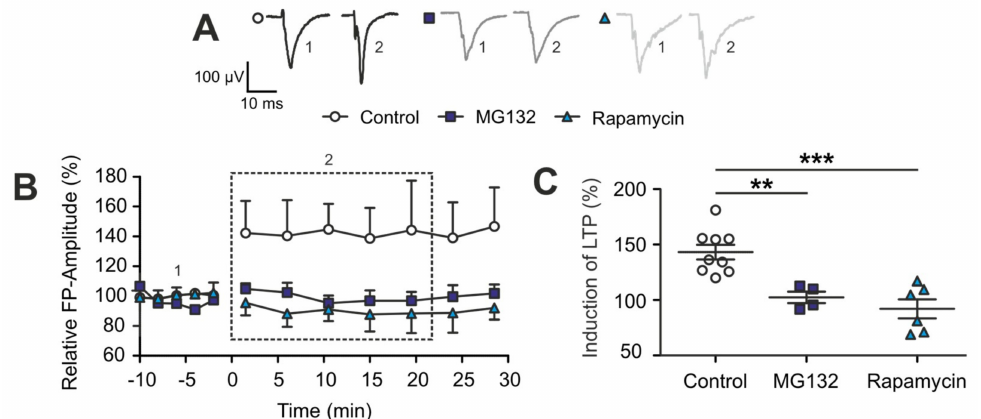
Figure 5. Pharmacological modulation of the two protein degradation systems induced TBI-like changes in l-LTP. ( A ) Representative voltage traces of evoked FPs recorded before (Pre-TBS, baseline, 1 in ( B )) and after electrical TBS stimulation (post-TBS, induction, 2 in ( B )) and under di ff erent pharmacological conditions. Cortical slices were used under control conditions (normal artificial cerebrospinal fluid (aCSF), control: n = 9 from 9 mice), in presence of MG132, a proteasome inhibitor ( n = 4 from 4 mice), and in presence of rapamycin, an activator of autophagy ( n = 6 from 6 mice). ( B ) Time course of relative FPs amplitudes pre- and post-TBS, data points represent the mean values for each condition (control: n = 9, MG132: n = 4, rapamycin: n = 6) relative to the individual recording’s baseline, error bars represent the SEM. The dashed rectangles represent the time windows considered for the induction phase of l-LTP (2: first 20 min of recording), as visualized in ( C ). Note, impairment of the proteasome or enhancement of autophagy suppressed the expression of l-LTP in wild type slices over the course of recording. ( C ) Scatter plot showing the abolished l-LTP under both pharmacological agents over a recording period of 20 min; data points represent the relative mean values for the first 20 min, the induction phase of LTP, for each recording; the mean and SEM are indicated by the black horizontal bars and error bars. The asterisks indicate the significance of the tested data in one-way ANOVA and post hoc LSD, significantly di ff erent values are indicated as **: p < 0.01, ***: p ≤